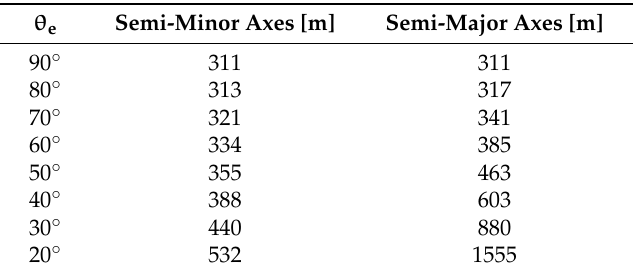
Table 3. Size of the semi-major and semi-minor axis of the first Fresnel zone for the CyGNSS scenario, as a function of the elevation angle θ e . θ e Semi-Minor Axes [m] Semi-Major Axes [m] 90 ◦ 311